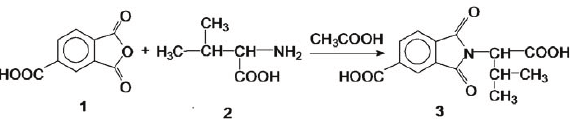
Figure 1. Synthetic route of N -trimellitylimido- L -valine 3 .